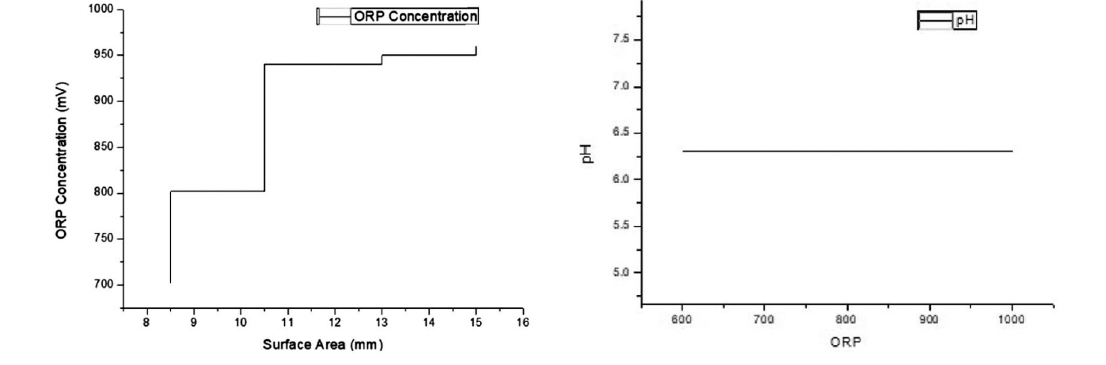
Fig. 3. ORP concentration vs surface area Fig. 4. pH vs ORP